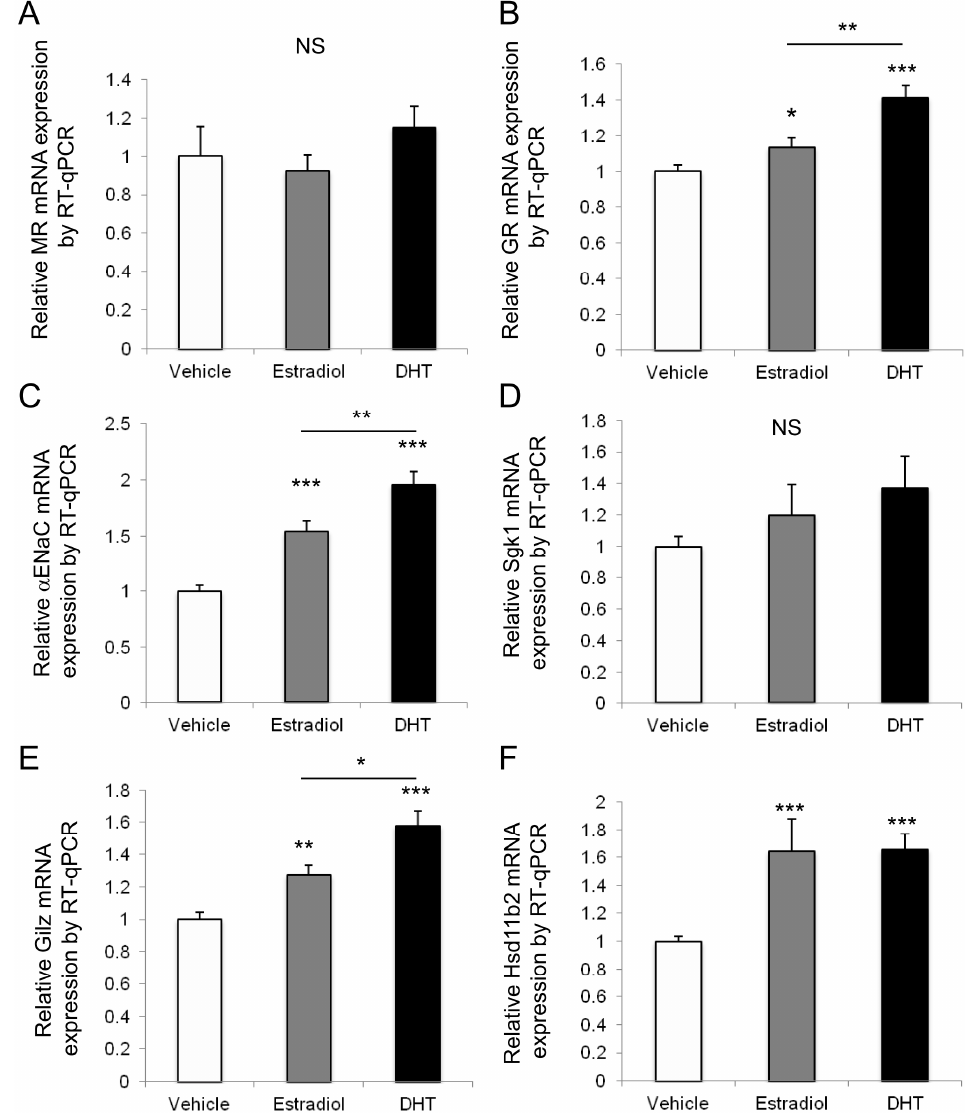
Figure 6. Sex hormone (estradiol and dihydrotestosterone, DHT) influence on the expression of MRs, GRs, Hsd11b2 and several MR-regulated target genes in vitro (in KC3AC1 renal tubular differentiated cells). MR ( A ); GR ( B ); α ENaC ( C ); Sgk1 ( D ); Gilz ( E ); and Hsd11b2 ( F ) relative mRNA expressions in KC3AC1 cells were determined using RT-qPCR, under various conditions: after 24 h of culture with either ethanol (vehicle), 10 − 7 M estradiol or 10 − 7 M DHT. Results, expressed as the ratio of attomoles of specific gene per attomoles of housekeeping gene, 36B4 , normalized to the expression obtained in cells incubated with vehicle arbitrarily set at 1, correspond to mean ± SEM of three independent reverse-transcriptions after RNA extraction of eight independent wells for each condition. * p < 0.05, ** p < 0.01, *** p < 0.001. NS: Not Significant.